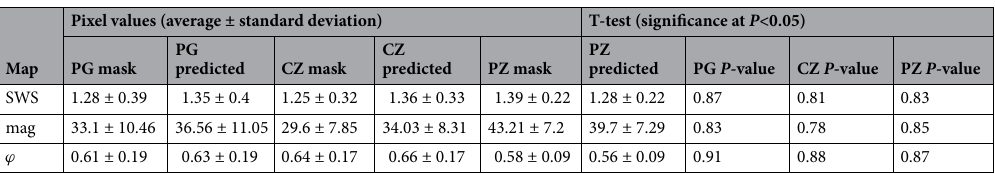
Pixel values (average ± standard deviation) T-test (significance at P Map